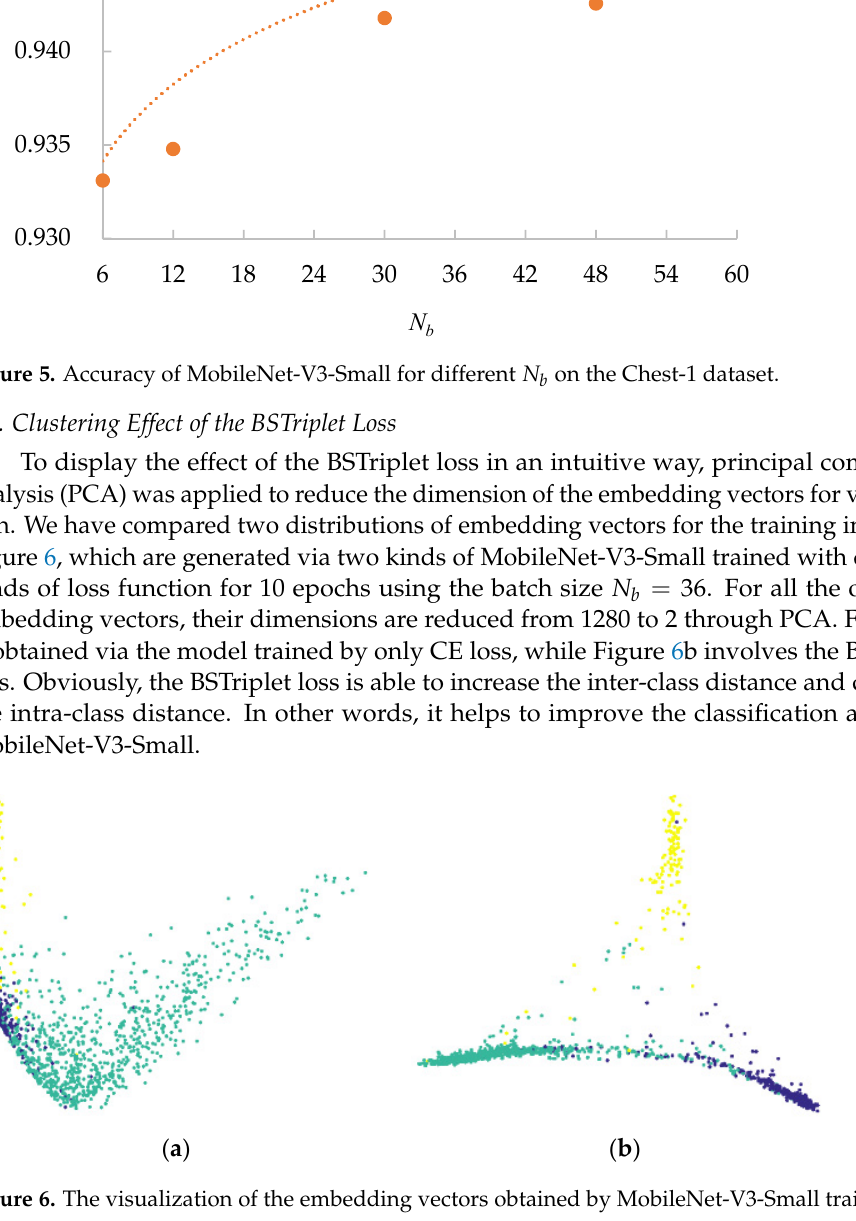
( b ) CE+BST Figure 7. Loss curves of different training schemes for MobileNet-V3-Small on the Chest-1 dataset. From Table 3, it can be seen that the data mining strategy used in the CE-based model can improve the accuracy by 1.21% compared with random selection. For the model based on CE+BST loss, its accuracy is improved by 0.90%. The results show that the proposed data mining strategy is helpful for training CNN models. Here, the strategy is more helpful for the CE-based model than for the CE+BST based one. The reason is that the BSTriplet loss can evaluate the data distribution of the training dataset to a certain extent, while the CE function lacks this ability. 0.00.20.40.60.8 1.0